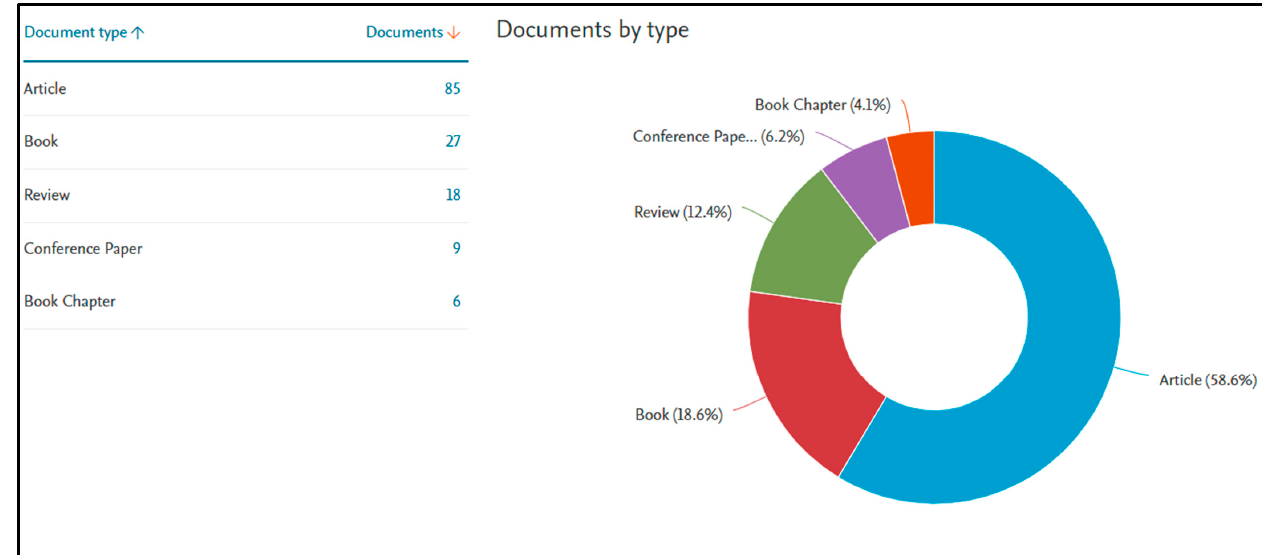
Figure 4. Popular document type.